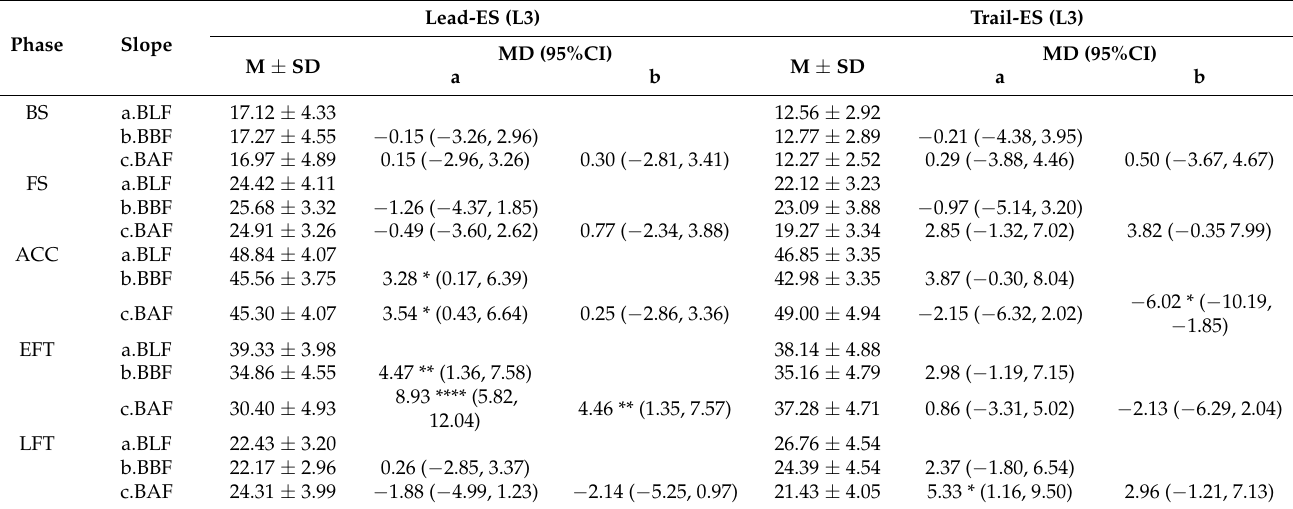
Table 3. EMG (MVC) by Lead-ES(L3) and Trail-ES(L3) muscle results for the BLF, BBF, and BAF at different